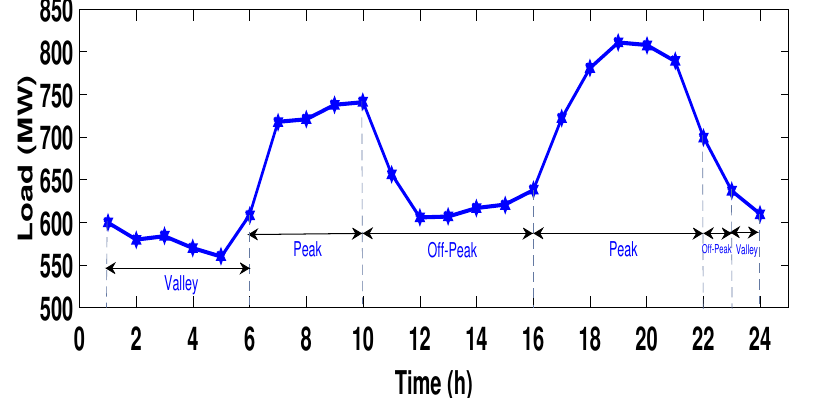
Figure 7. Load demand curve of NEPS [17].